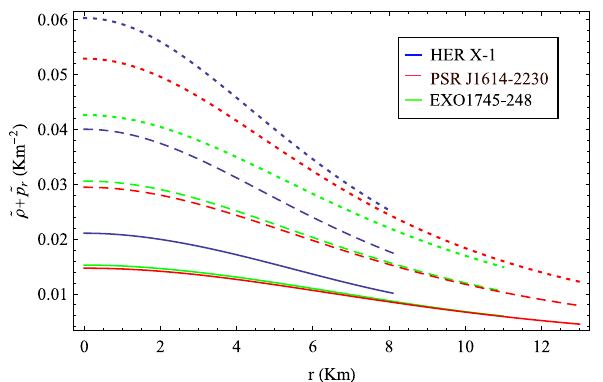
Fig. 10 Radial variation of ˜ ρ + ˜ p r for different compact objects as indicated in the figure. Here plots with solid, dashed and dotted lines correspond to D = 4 , 5 and 6 respectively. To obtain the plots we choose (i) α = 0 . 4, γ = 0 . 45 when D = 4; α = 0 . 3, γ = 0 . 25 when D = 5 and α = 0 . 25, γ = 0 . 2 when D = 6 for HER X-1, (ii) α = 0 . 4, γ = 0 . 5 when D = 4; α = 0 . 3, γ = 0 . 25 when D = 5 and α = 0 . 2, γ = 0 . 15 when D = 6 for PSR J1614-2230, (iii) α = 0 . 4, γ = 0 . 5 when D = 4; α = 0 . 3, γ = 0 . 2 when D = 5 and α = 0 . 2, γ = 0 . 25 when D = 6 for EXO1745-248